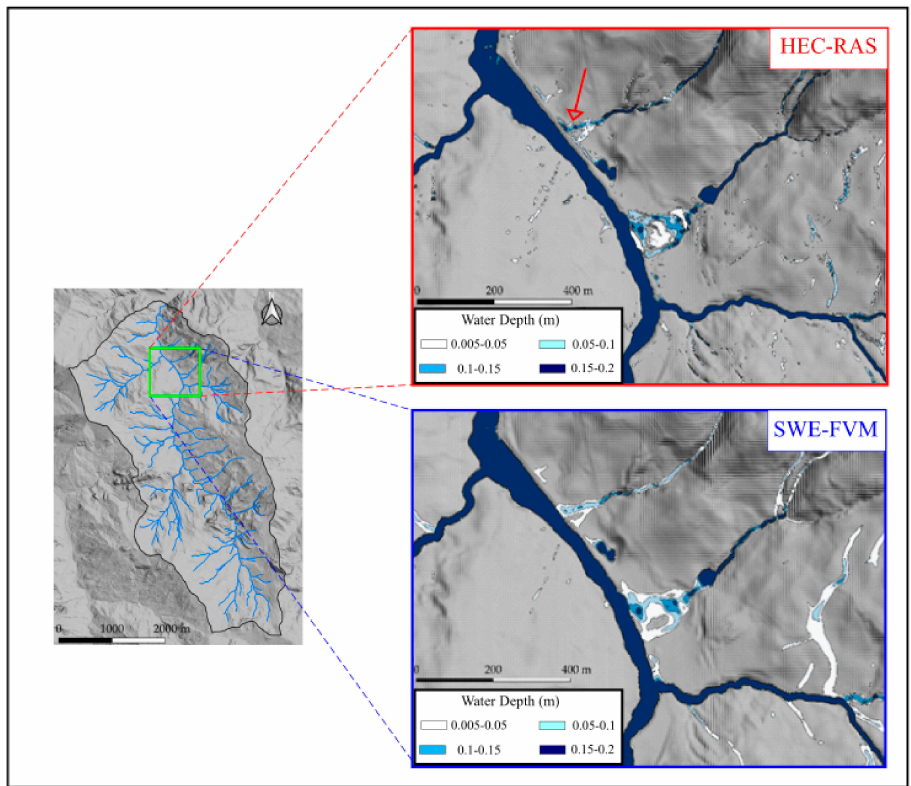
Figure 7. Detail of the flooded areas computed by HEC-RAS and SWE-FVM for water depth threshold equal to 0.05 m, considering T = 200 years and grid size 5